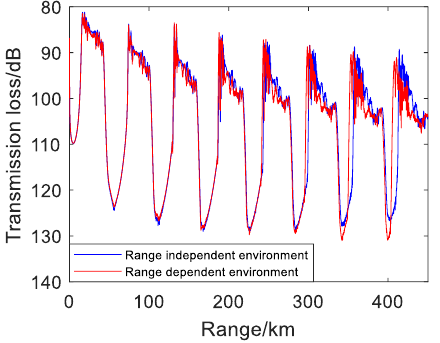
loss. A comparison of the obtained transmission losses is shown in Figure 3.